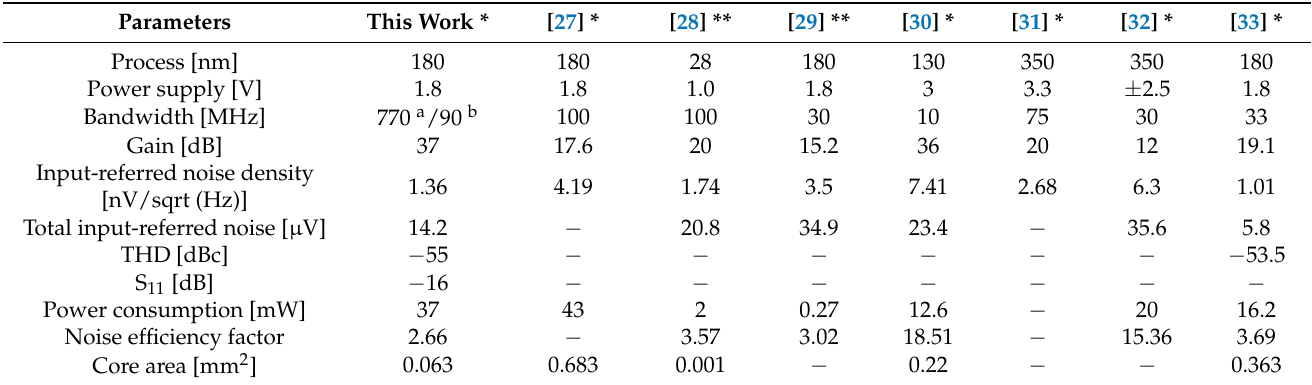
Table 2. LNA front-end performance